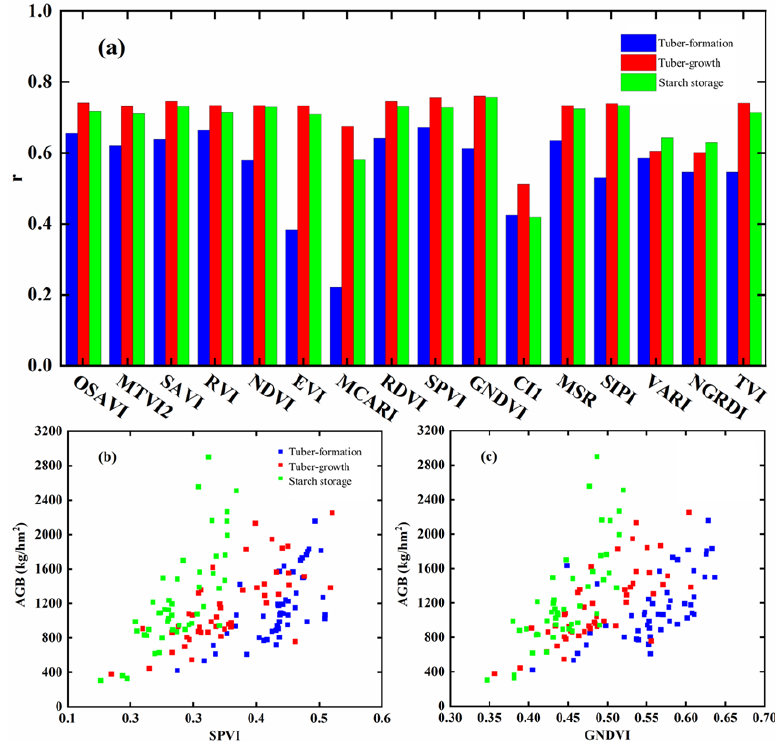
Figure 5. Pearson correlation analyses of above-ground biomass (AGB) of potatoes with VIs for different growth stages. ( a ) Absolute correlation coefficient for VIs versus AGB for tuber-formation, tuber-growth, and starch-storage periods. ( b , c ) Scatter plots of the best performing VIs versus AGB for each growth period.